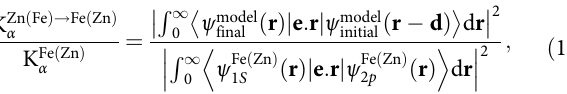
plotted the DFT-predicted ratio of the inter-atomic K α signal to the corresponding intra-atomic emission K Fe α (or K Zn α ) (by the red diamond symbols in Fig. 5) as a function of inter-atomic distance between Fe and Zn ions. For a chosen Fe – Zn plasma density varying from ρ = 250 g cm − 3 to ρ = 2000 g cm − 3 at the same temperature of kT = 50 eV, we derived the d corresponds to the peak location of the pair distribution